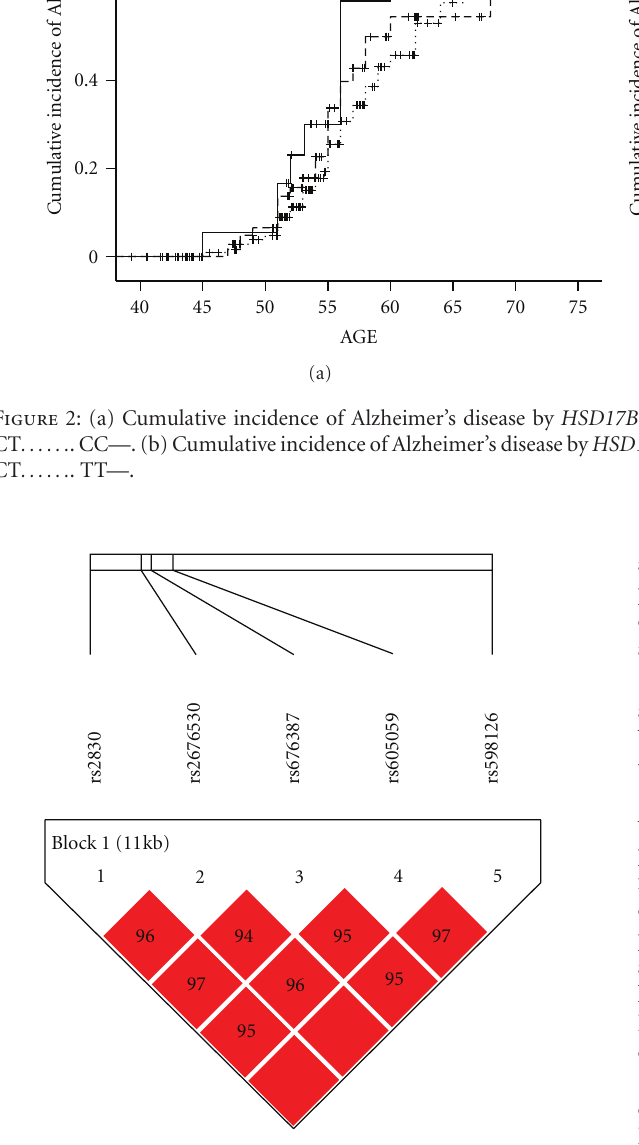
genotype. Women with DS homozygous for the T allele at rs676387 or the C allele at rs598126 had 2.7 and 2.2-fold increased risk of AD, respectively, compared with women without these risk alleles, although risk was only slightly in- creased in women who were heterozygous for the risk allele. Carrying a high-risk allele at rs605059 was associated with both early onset and higher cumulative incidence, while carrying a high-risk allele at rs676387 or at rs598126